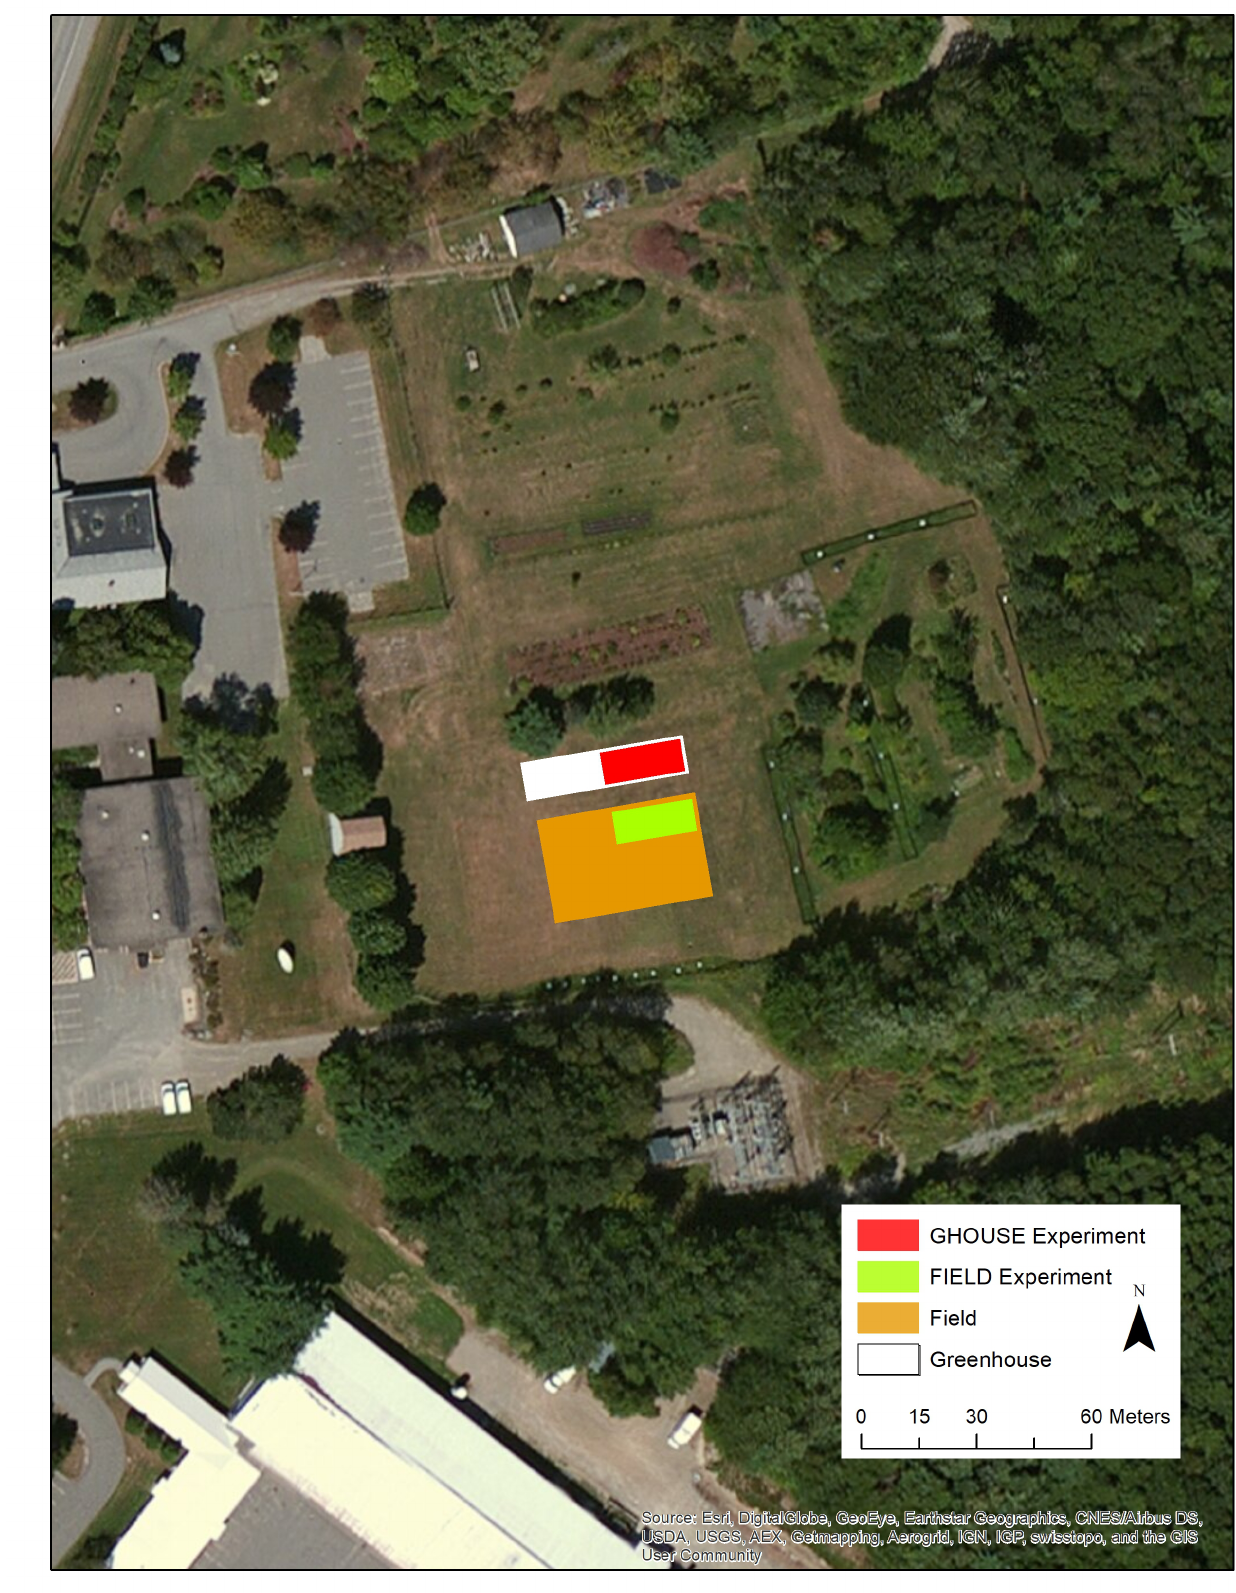
Figure A1. Aerial view showing FIELD and GHOUSE experiment locations.